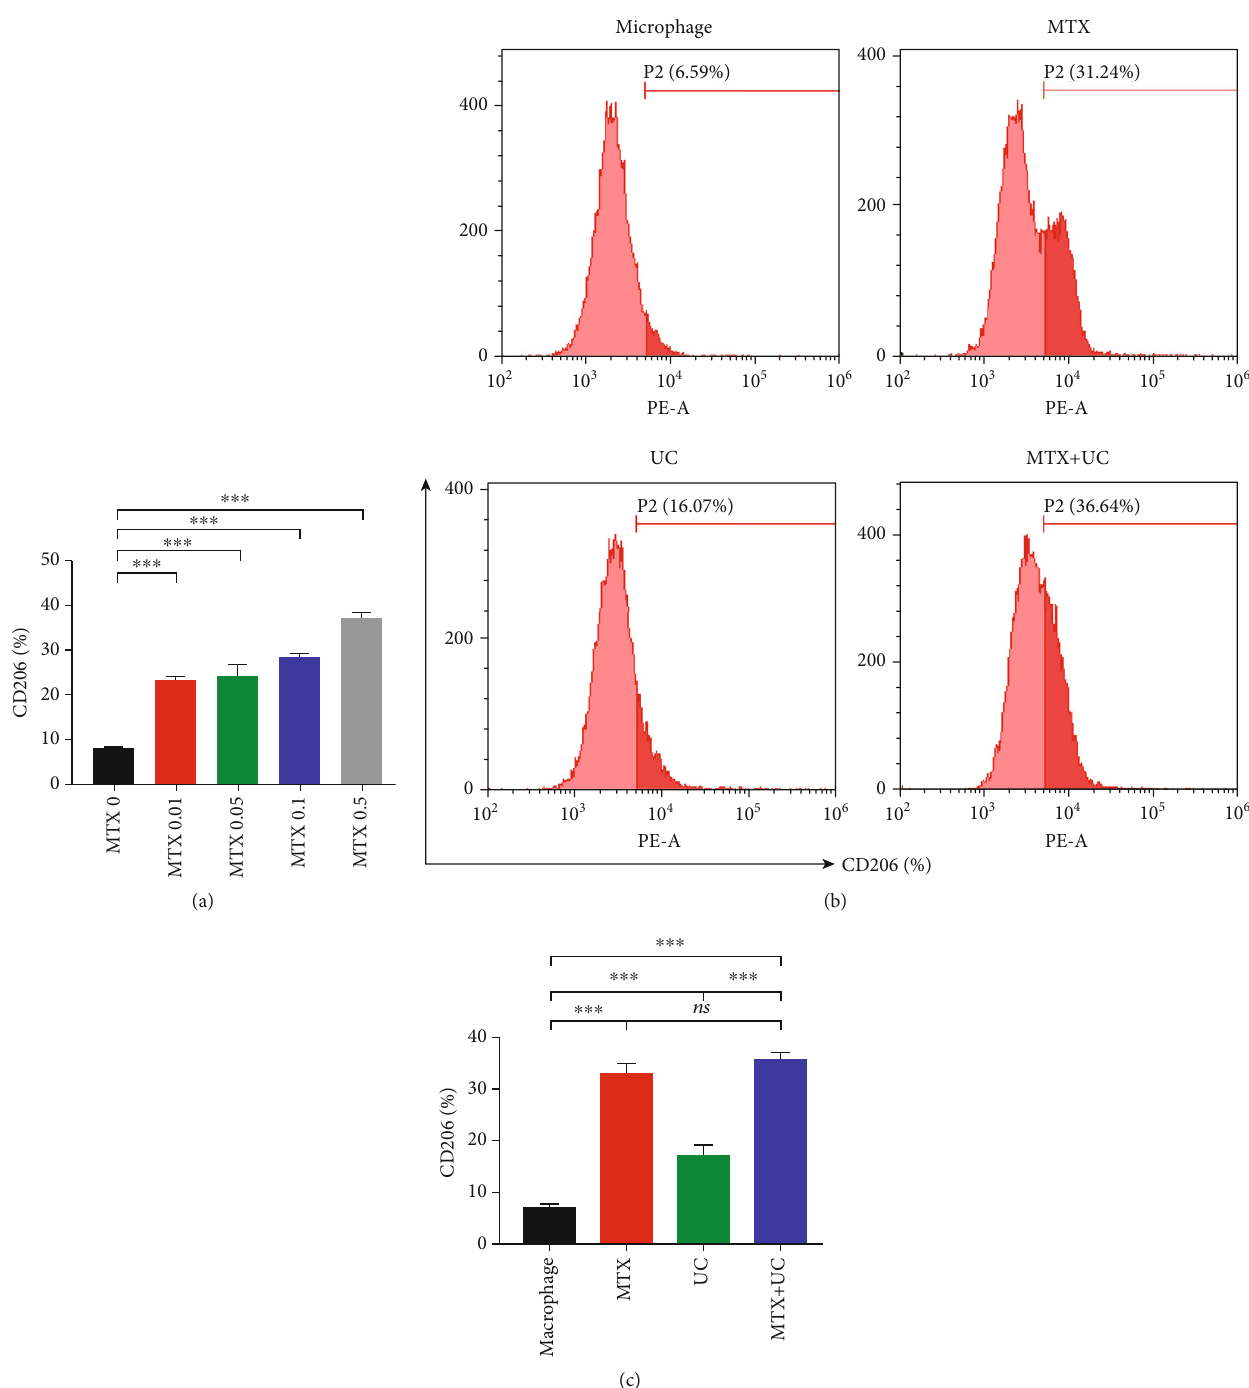
Figure 5: MTX prefers to facilitate macrophage polarization to M2 type. (a) MTX induced an increase of M2 macrophage polarization in a concentration-dependent manner in vitro. (b) The proportion of M2 phenotype macrophages in four groups was analyzed by fl ow cytometry. (c) The quanti fi cation showed that both MTX-treated macrophages and MTX+UC-treated macrophages showed more proportion of CD206-positive cells than macrophages cocultured with UCs. n = 3 per group. Data are shown as mean ± SD . ∗ P < 0 : 05 ; ∗∗ P < 0 : 01 ; ∗∗∗ P < 0 : 001 ; ns: not signi fi cant ( P > 0 : 05